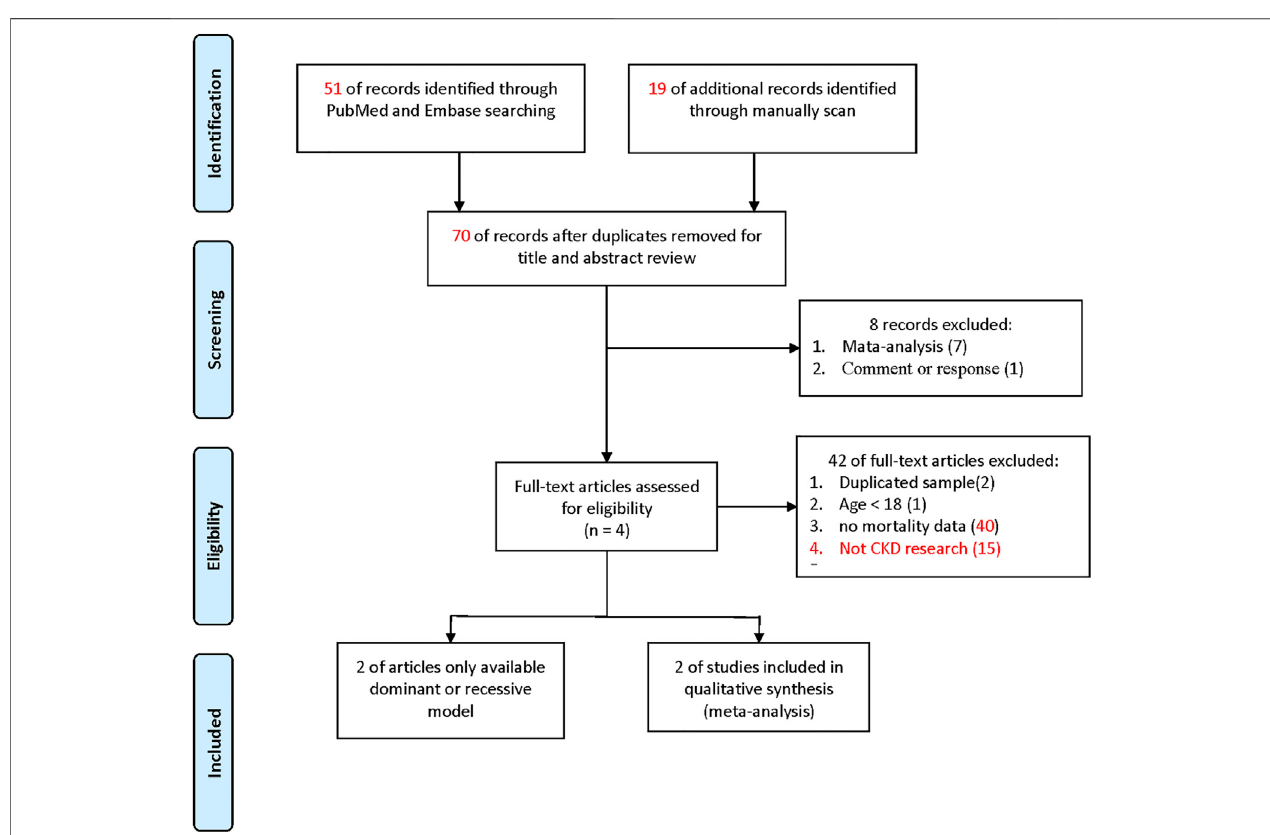
FIGURE 1 | Flow diagram of the identi fi cation process for eligible